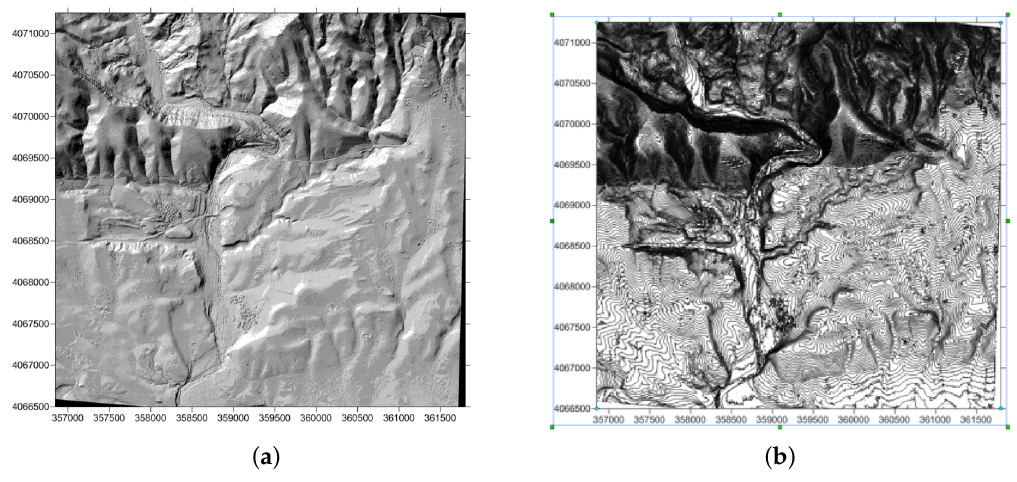
Figure 11. ( a ) shaded visualization of the DEM and ( b ) the contour lines with 2 m steps.